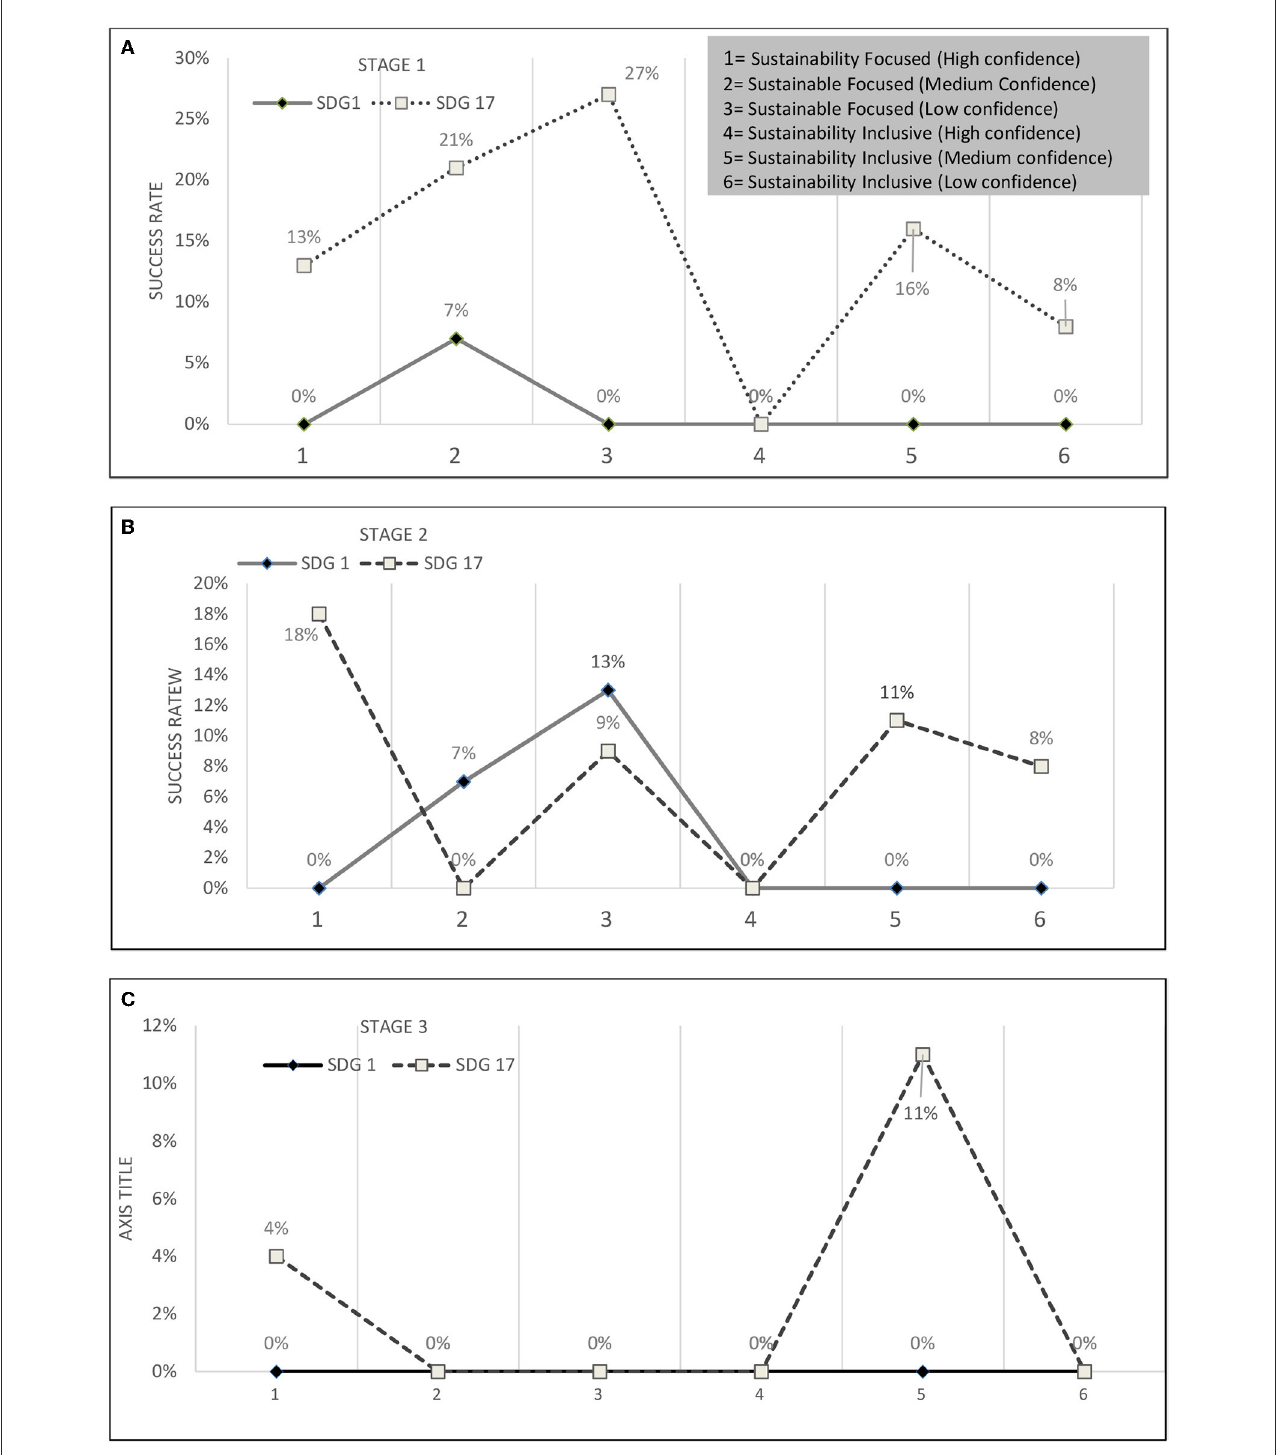
FIGURE5 AASHE-STARS category success rate for SDGs 1 and 17. Stage 1, 2, and 3 correspond to the review of module description, learning outcomes and module aims respectively. (A) Stage 1. (B) Stage 2. (C) Stage